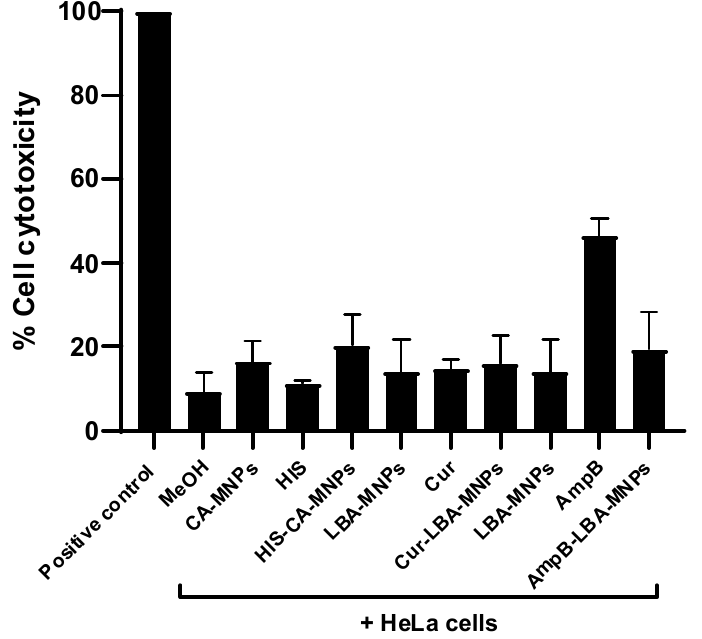
Figure 6. Drugs and drug-loaded MNPs revealed negligible cytotoxic effects against HeLa cell lines. Human cells were grown in 96-well plates up to 80–90% confluency, as discussed in Materials and Methods. Next, cell monolayer was treated with NPs, drugs, and drug–NP combinations for 24 h at 37 ◦ C in 95% humidity and 5% CO 2 . Cells alone in RPMI were taken as negative control. The data are presented as the mean ± standard error of several independent experiments performed in dupli- cates. Data were analyzed using Graph Pad Prism software (8.0.2).